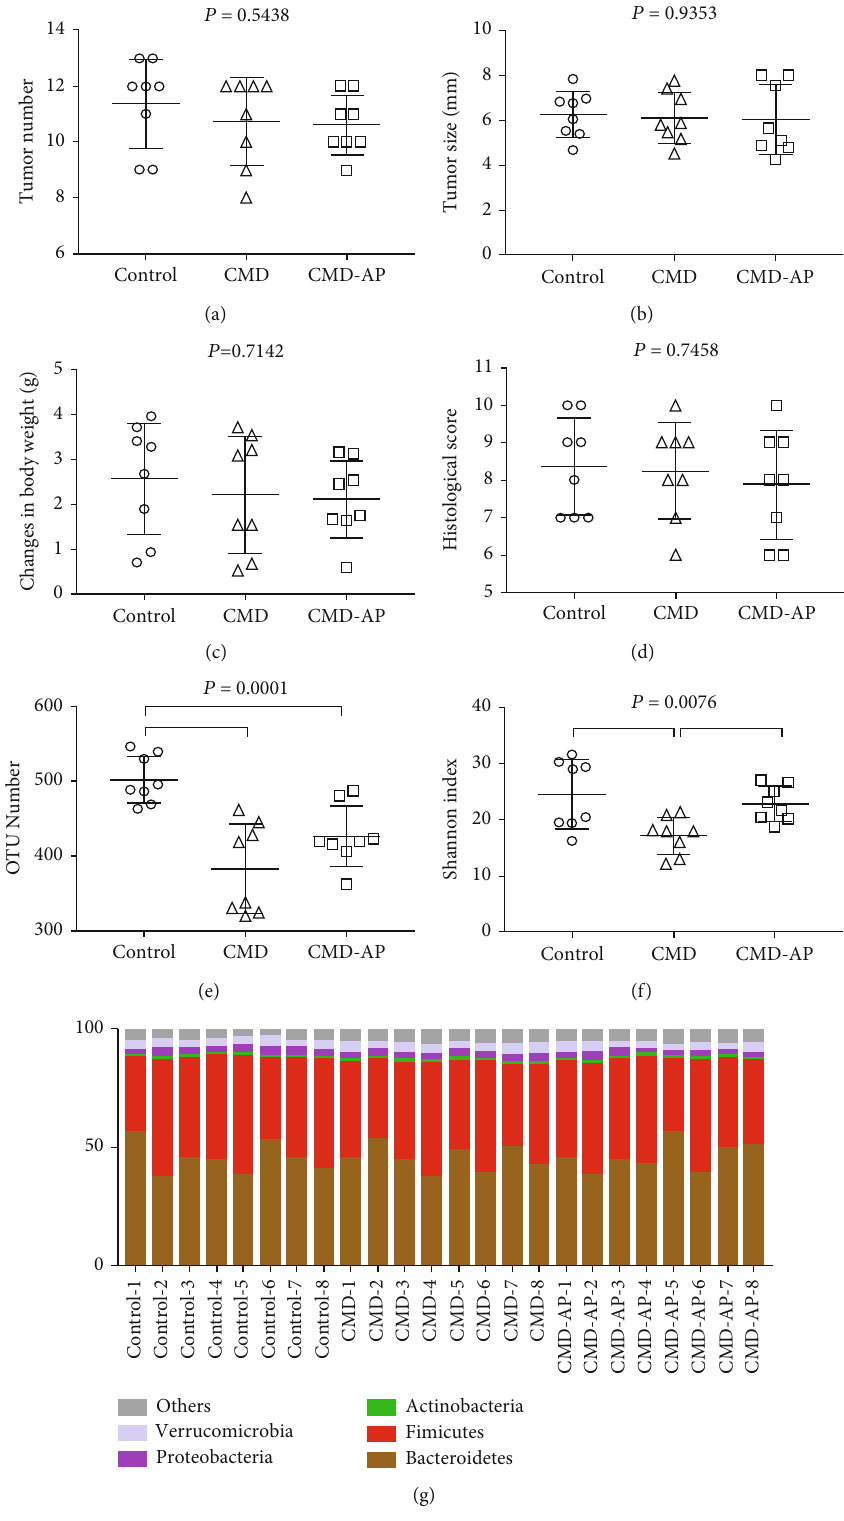
Figure 3: In fl uence of gut microbiota depletion on the antitumor e ff ects of apigenin. The number (a) and size (b) of colon tumors in the CMD and CMD-AP groups; (c) change in body weight, (d) histological scores, (e) OTU number, (f) diversity indexes, and (g) the abundance of gut microbiota at the phylum level in the commensal microbe-depleted (CMD) experiment; n = 8